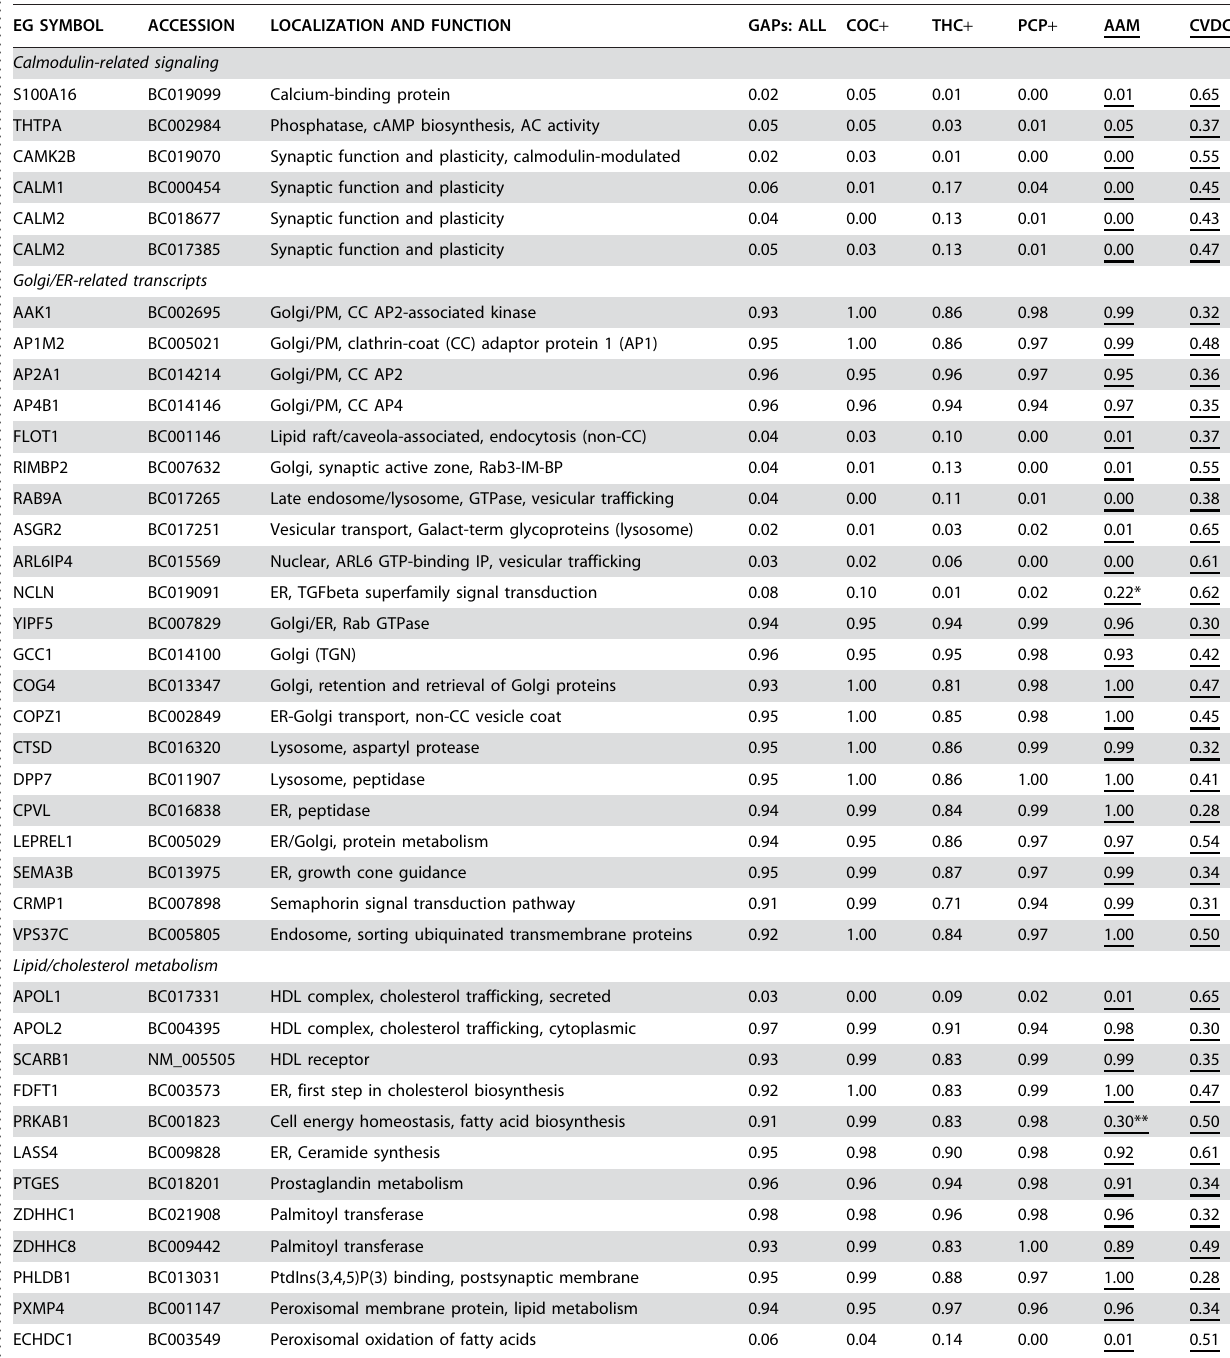
Table 3. Significantly regulated transcripts identify three functional groups as shared across cocaine, cannabis and phencyclidine